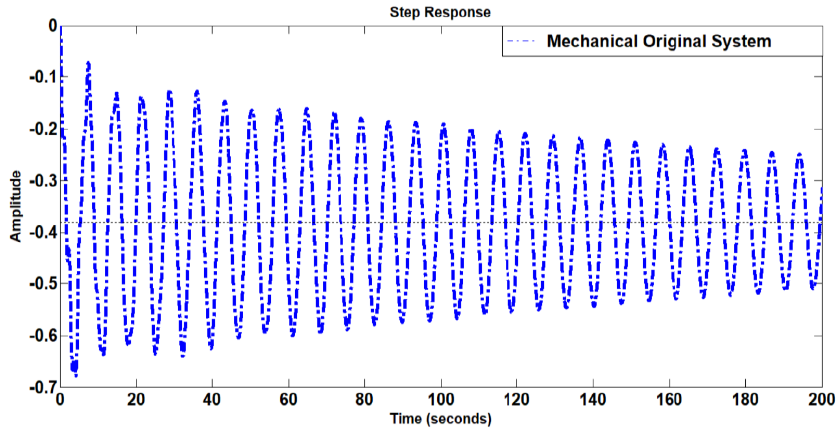
Figure 7. Time response of mechanical